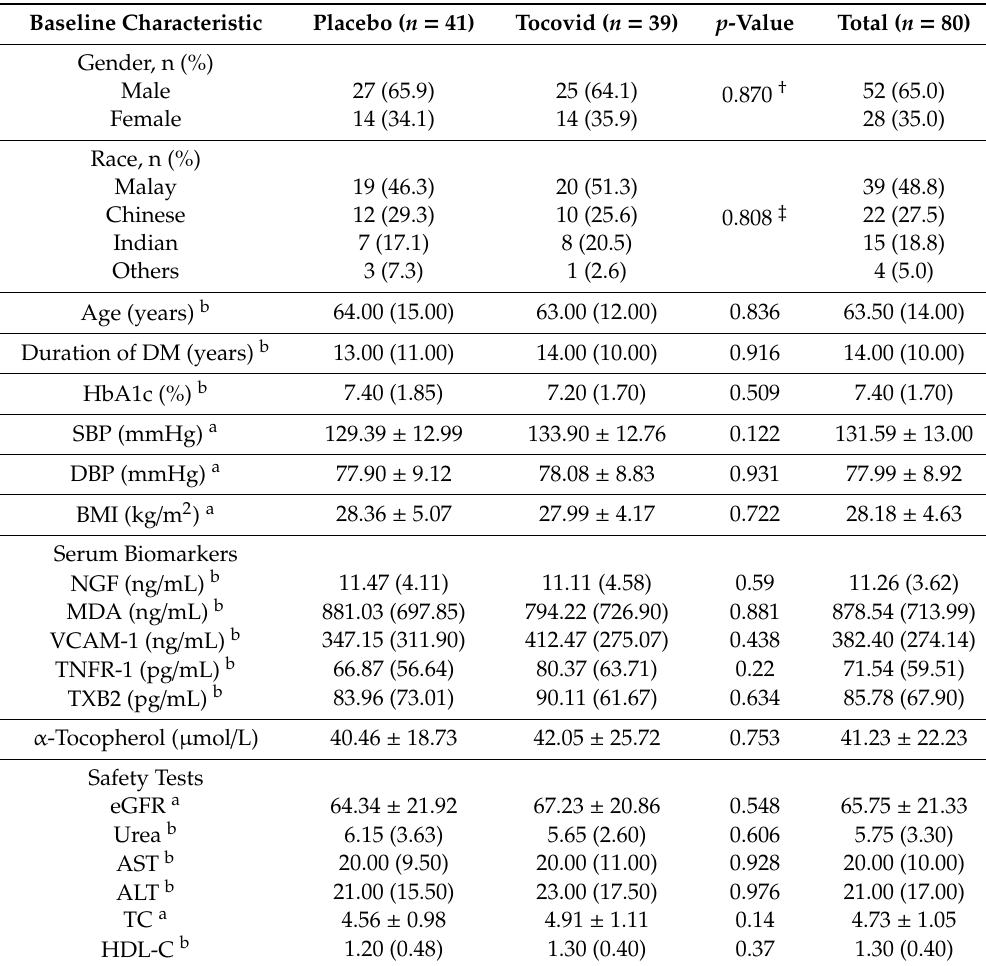
Table 2. Baseline characteristics of study